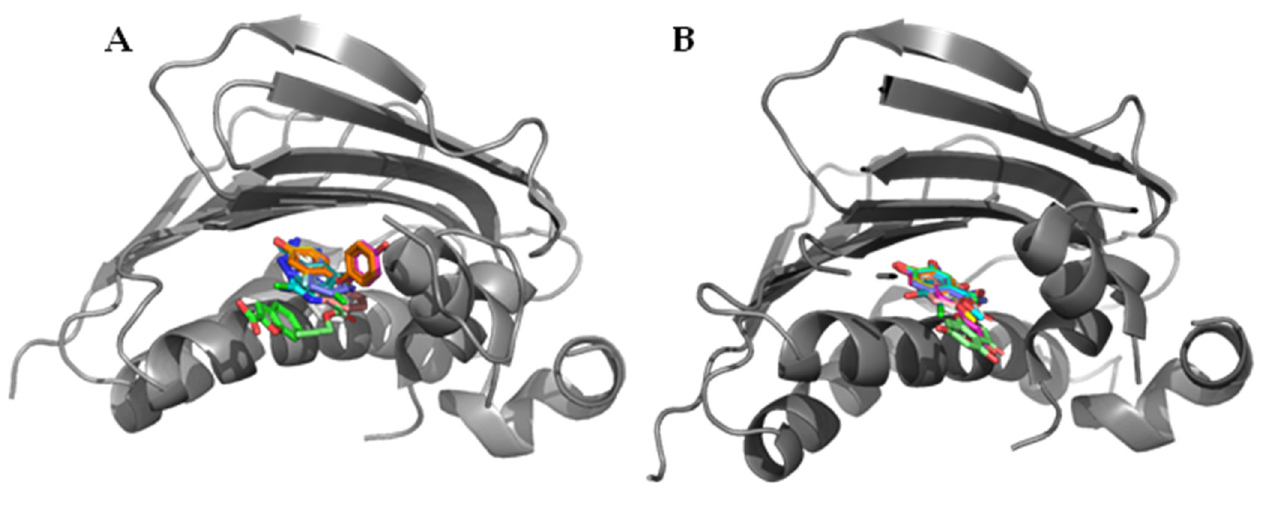
Figure 8. Superimposed co-crystal structures of fragments bound to the ATPase sub-domain of DNA gyrase identified by ( A ) Huang et al. and ( B ) Yu et al. [64,65]. A wider range of positions and functional groups were found in crystals produced by Huang et al., including one fragment (green) which filled a similar space to novobiocin. In comparison, the work by Yu et al. found one dominant binding mode, but multiple examples of phenols in this position suggest it may be a favourable binding mode for fragments of this class (PDB IDs ( A ): 5Z9N, 5Z9N, 5Z4H, 5Z9L, 5Z9P, 5Z9Q, 5Z9F, 5Z4O, 5Z9E, 5Z9B; PDB IDs ( B ): 7DOR, 7DPR, 7DPS, 7DQF, 7DQH, 7DQI, 7DQJ, 7DQL, 7DQM, 7DQS, 7DQU,